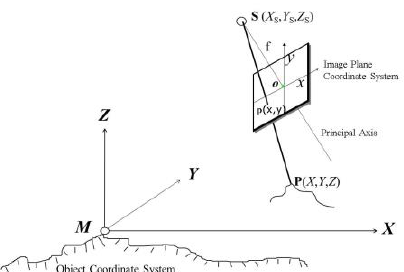
Figure 1. The geometric configuration of perspective projection defined by the collinearity equation